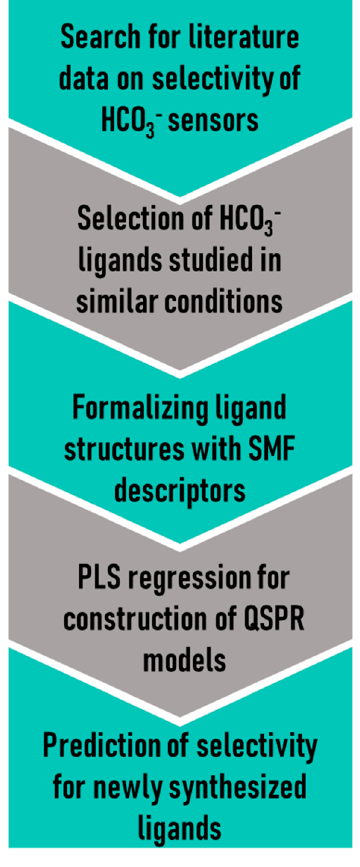
Figure 1. The sequence of the experiment.